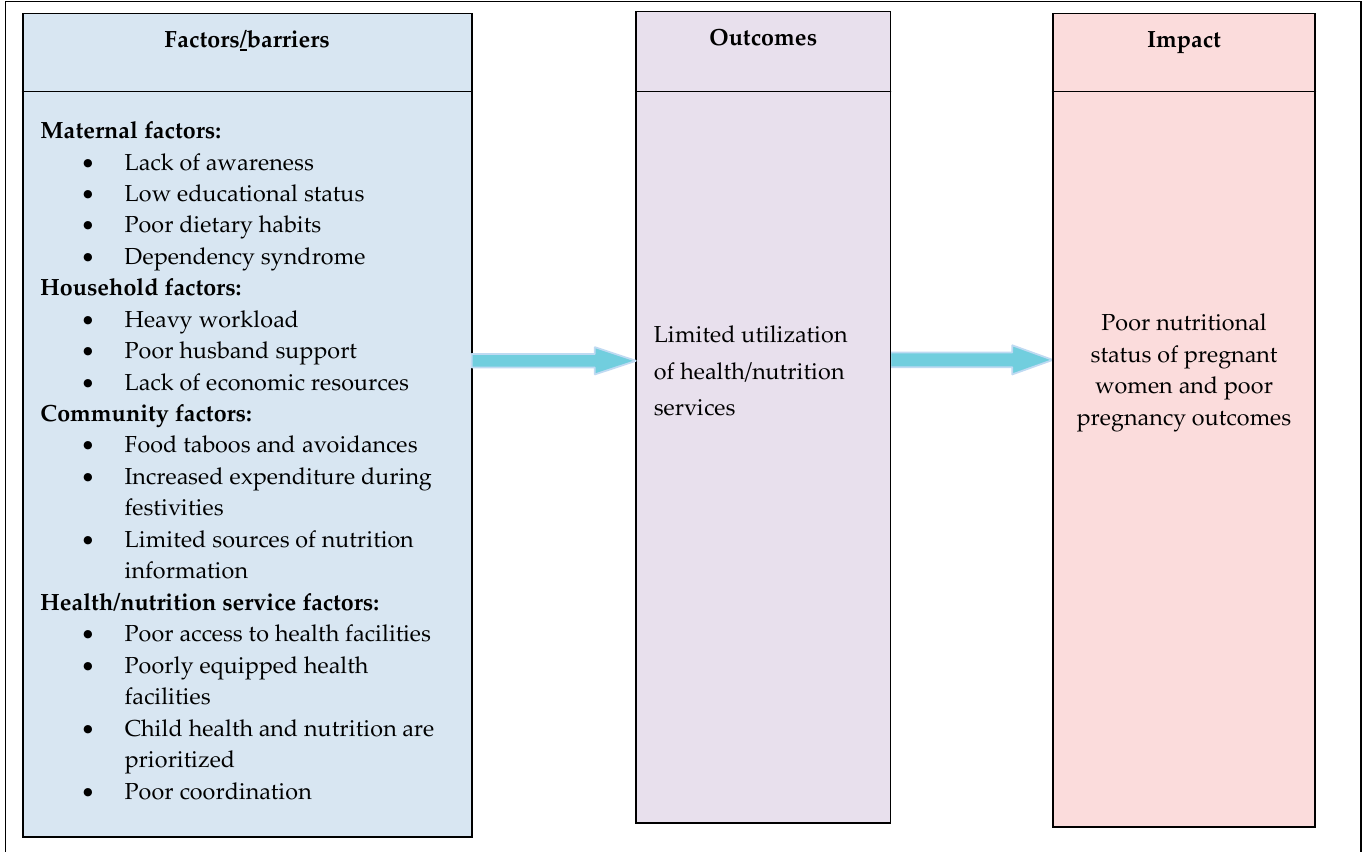
Figure 2. Conceptual framework of factors/barriers limiting the uptake of nutrition services during pregnancy among women from rural communities of Tigray, Northern Ethiopia, 2017/18.